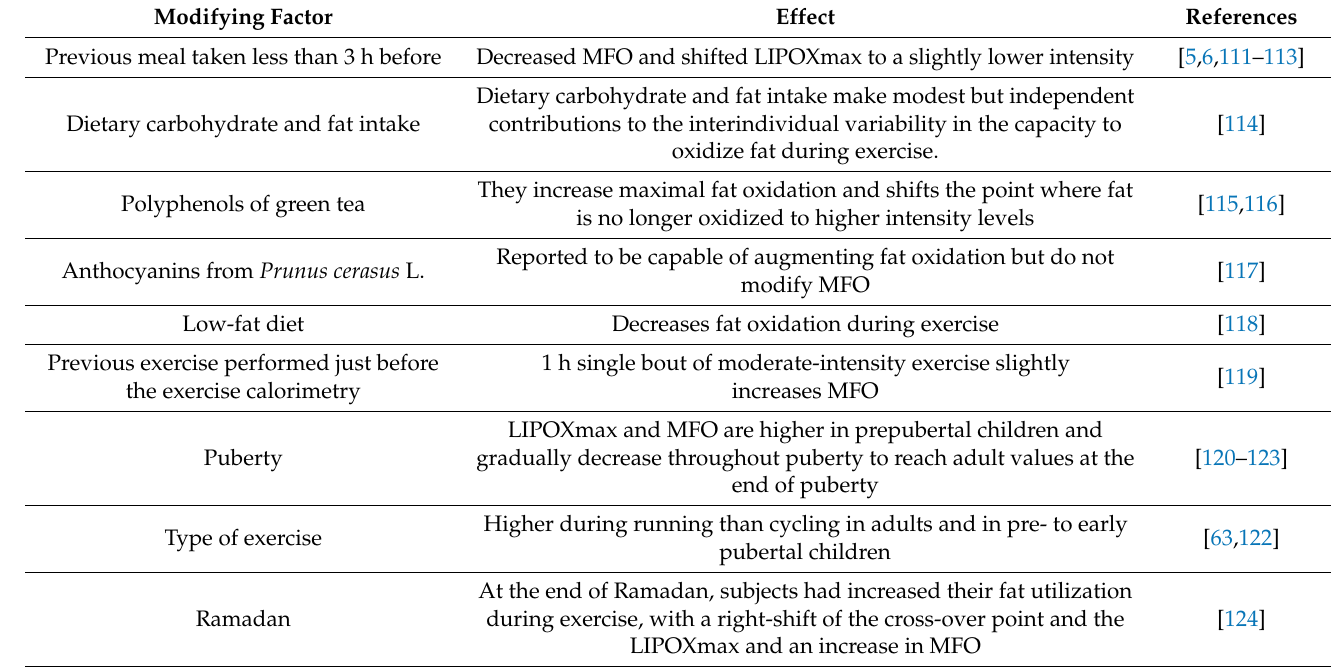
Table 1. Factors, diseases, and physiological situations that have been studied for their effect, or lack of effect, on the ability to oxidize lipids during